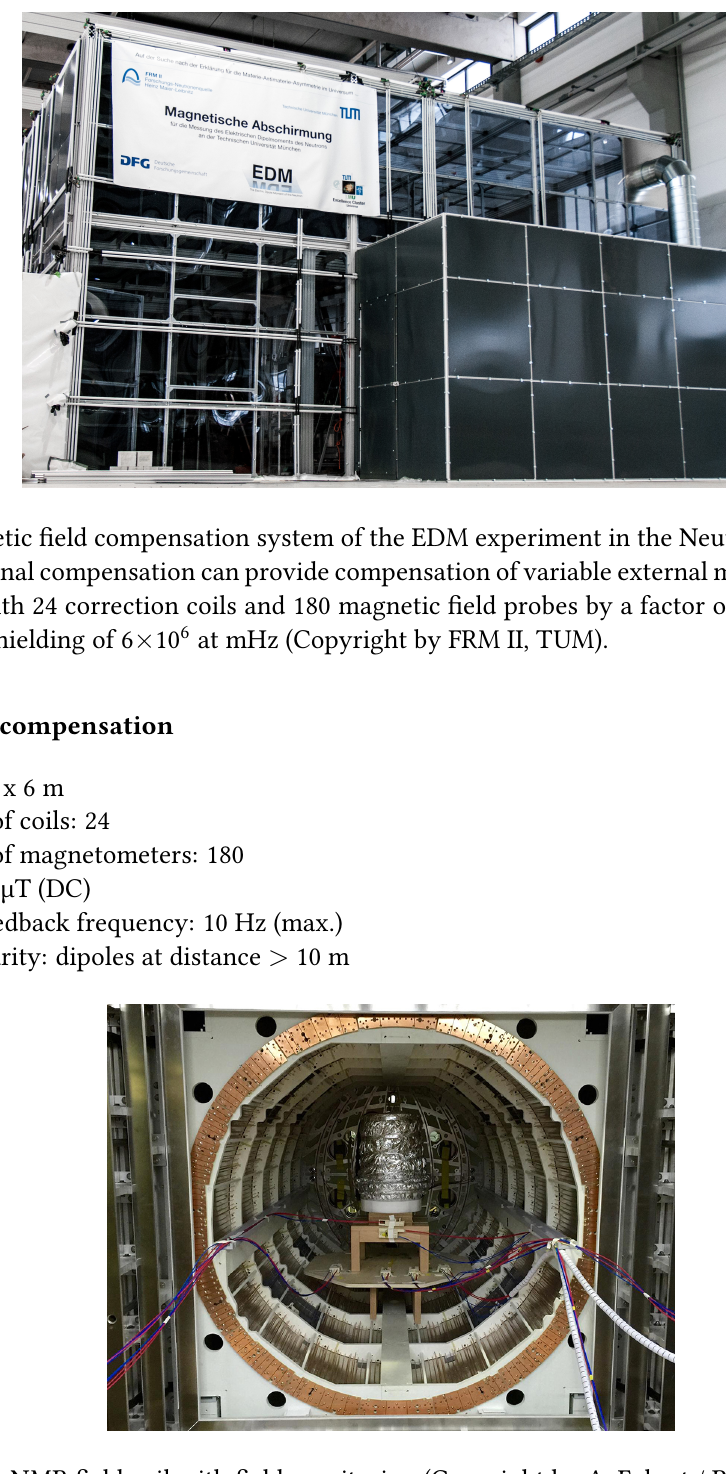
Figure 2: NMR field coil with field monitoring (Copyright by A. Eckert /